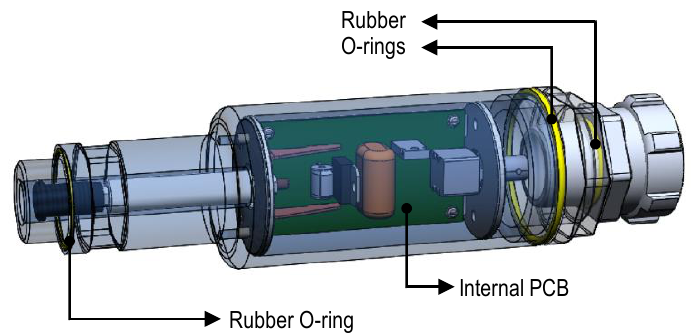
Figure 5. Rubber O-rings on the coupling device to prevent moisture during the test tap.